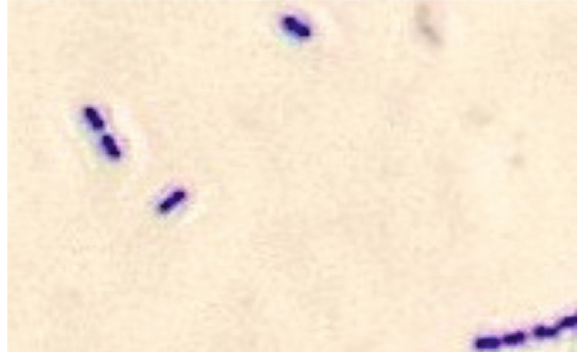
Figure 1: Microscopy. Gram-stain smear (1000 × magni fi cation) showing gram-positive (violet) cocci in chains consistent with Lactococcus